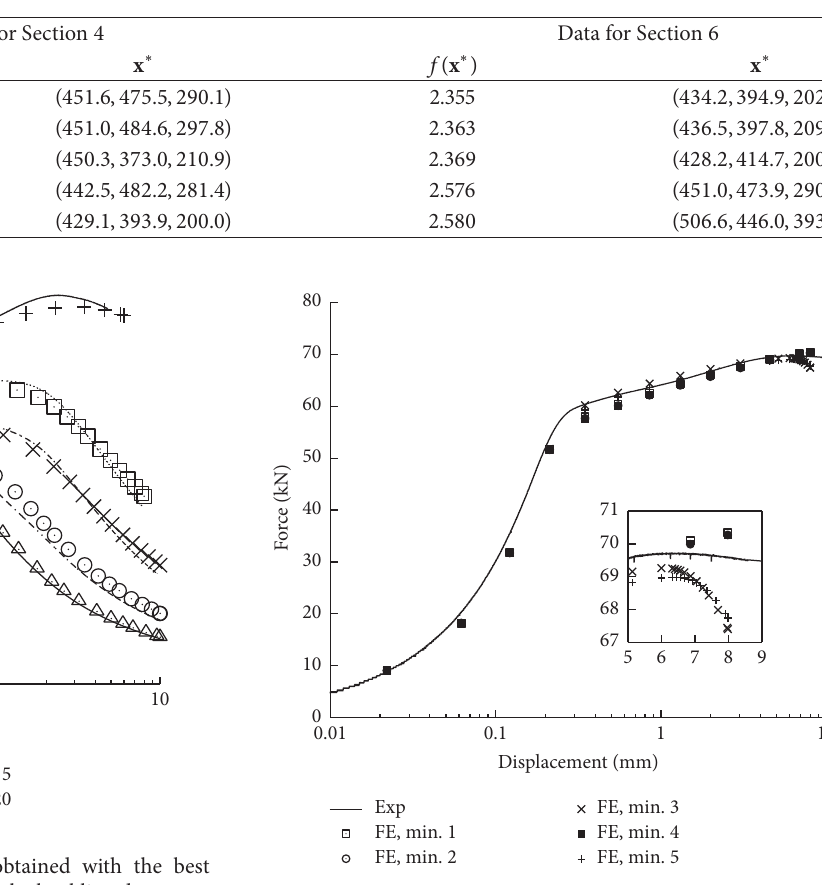
Figure 9: FE load/displacement traces calculated with the harden- ing properties of Table 3 are shown with symbols. The solid line shows the experimental